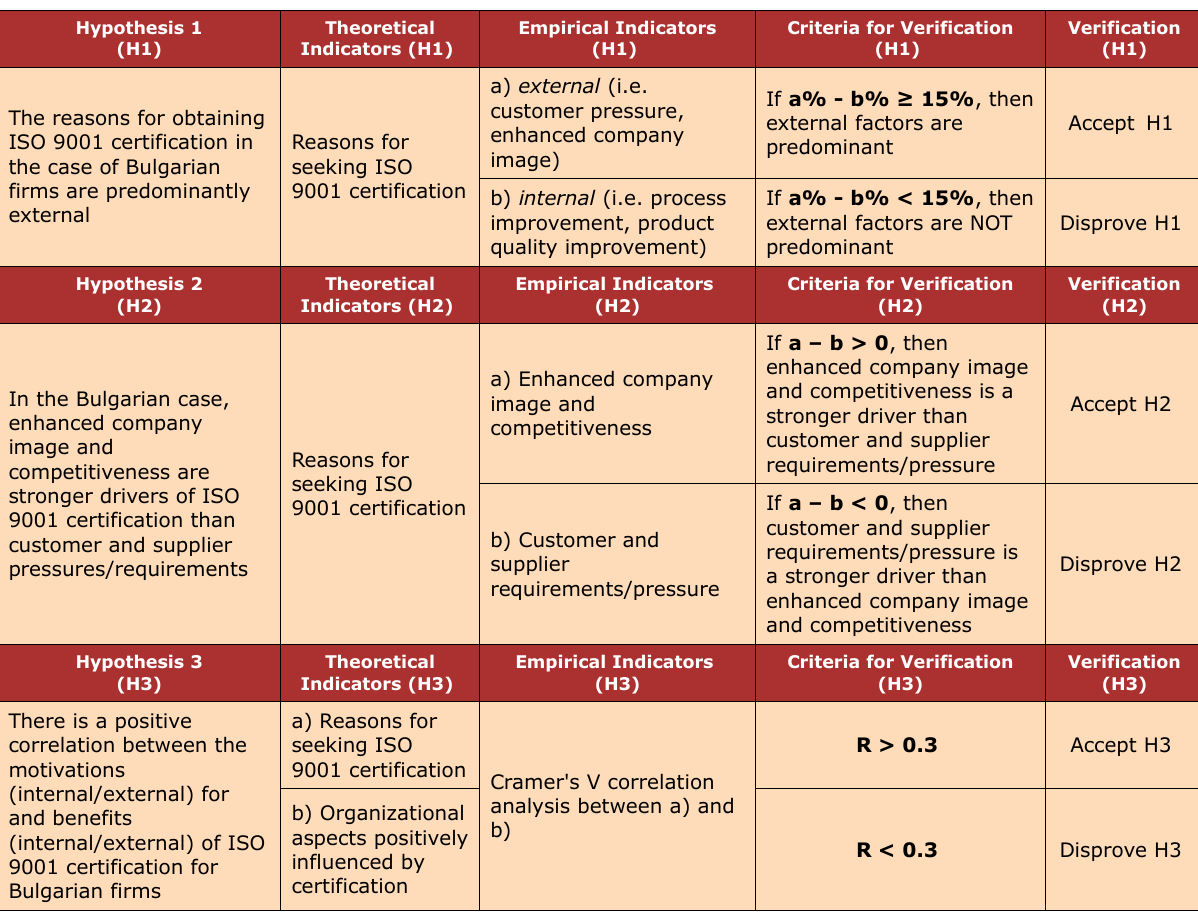
Table 6. Framework for Analysis & Criteria for Hypothesis